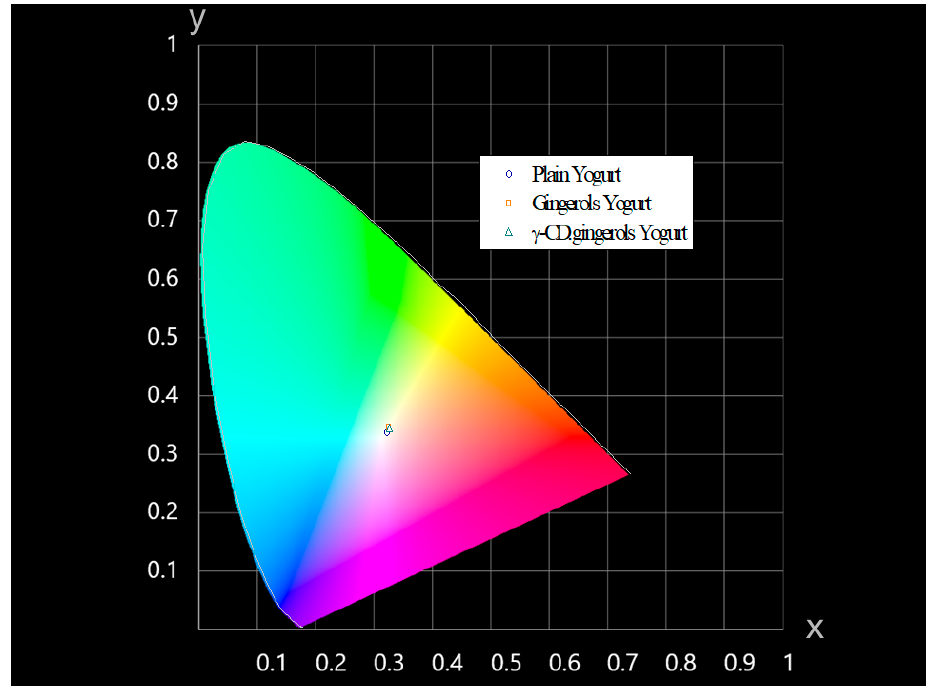
Figure 5. Chromaticity diagram with the representation of the colour coordinates of plain yogurt and fortified yogurt samples. Data corresponds to the mean value of readings of three different samples from each batch.